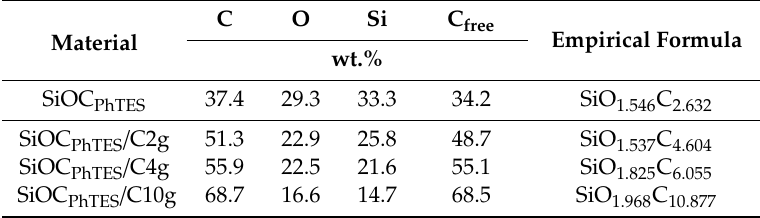
Table 1. Results of elemental analysis of SiOC PhTES and SiOC PhTES / graphite composites.